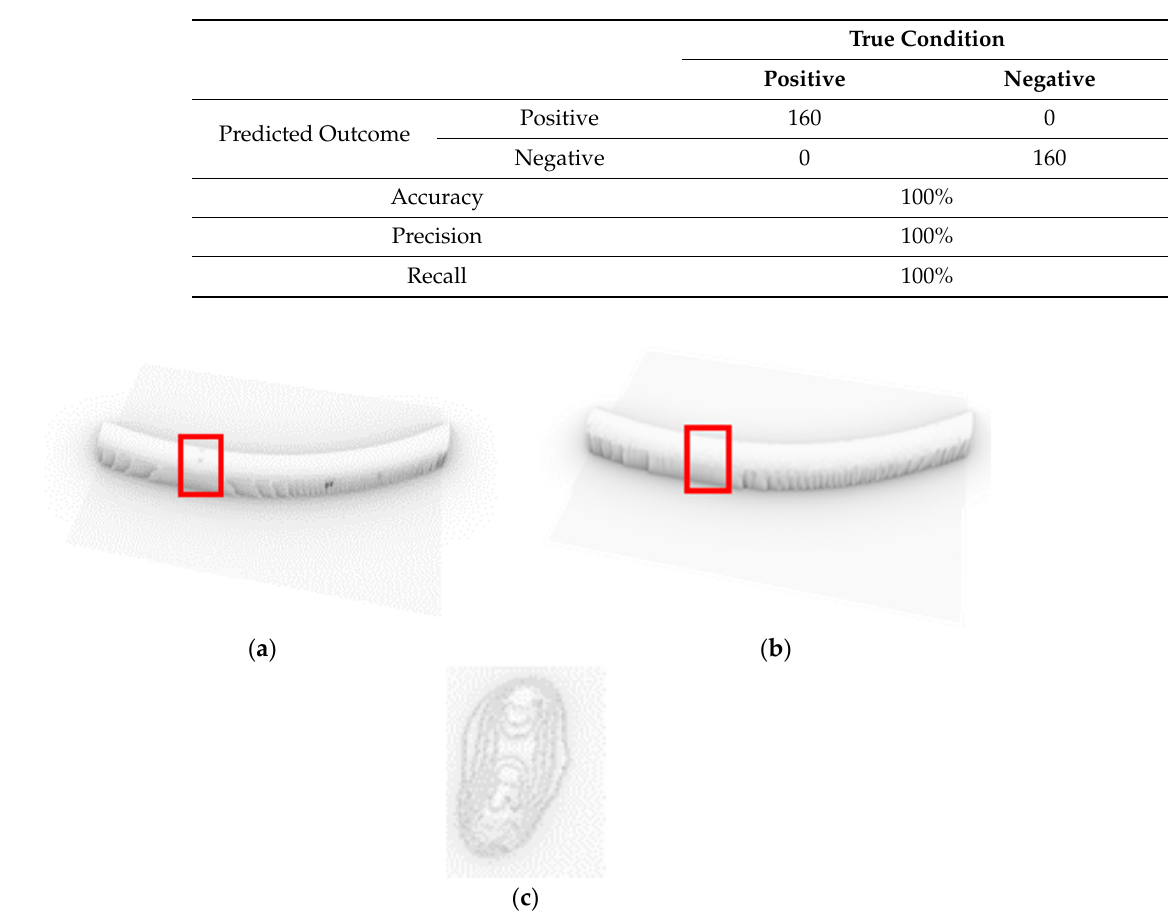
S ; ( c ) subtracting result on defect candidate